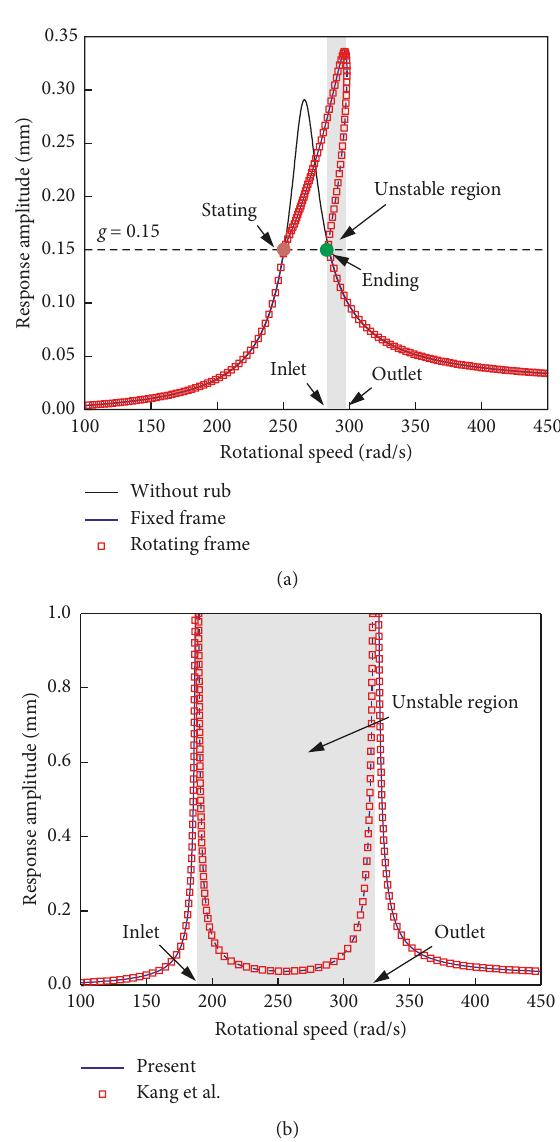
Figure 4: The horizontal amplitudes of disk node versus rotational speed: (a) symmetric rotor with rub-impact and (b) asymmetric rotor without